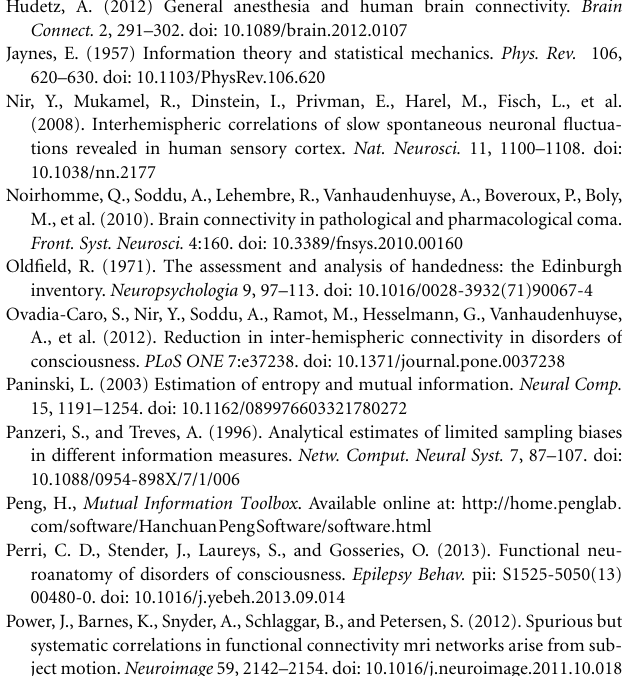
Figure S1 | DOC impairment evaluated at specific brain areas. (A) Decorrelation indices defined as (corrG1-corrG2)/corrG1 computed for each of the different 45 brain areas. In blue, top-five values of decorrelation index; in red, bottom five (positive) values. (B) Scatter of between-homologue inter-hemispheric correlations G1 vs. G2, each point represents one of the 45 brain